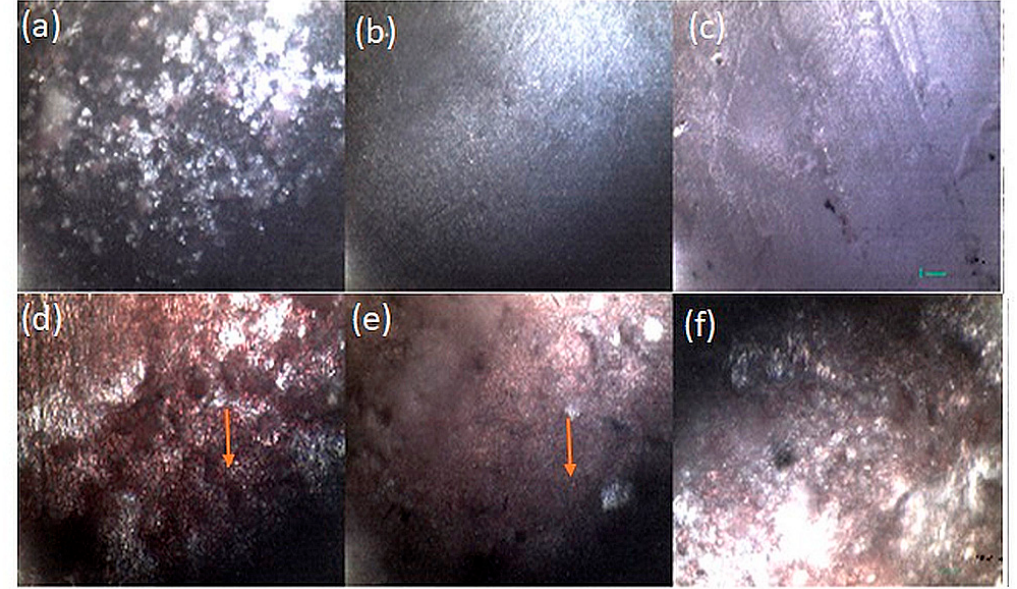
Figure 7. Optical microscopic images of Si–HA discs at ( a ) 30 min, ( b ) 2 h and ( c ) 6 h and Si–HA-coated samples at ( d ) 30 min, ( e ) 2 h and ( f ) 6 h of Mg–HA. Arrows indicate the presence of S. aureus on substrate surface. Scale bar ~150 µm.